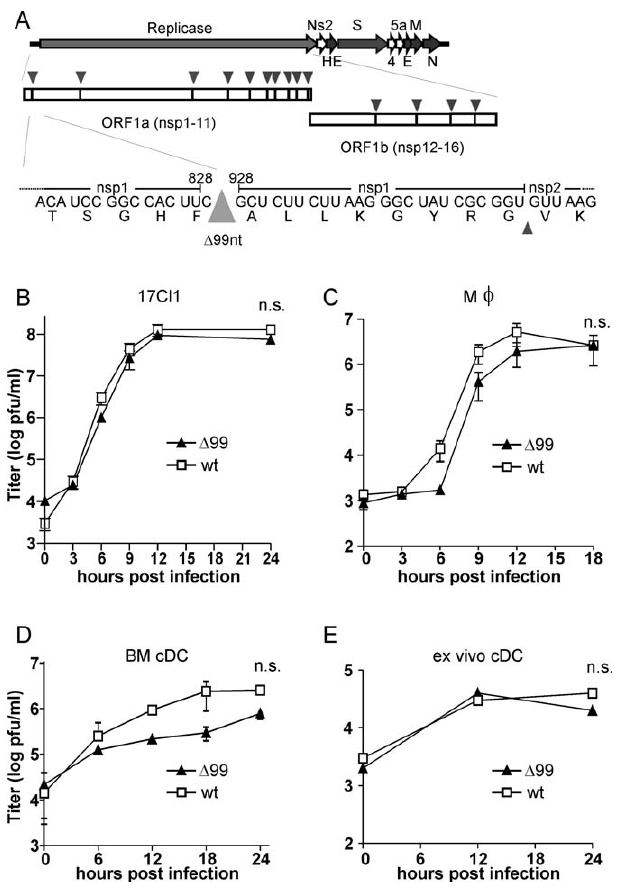
Figure 2. Construction and In Vitro Analysis of MHV-nsp1 D 99 (A) Schematic representation of the MHV-nsp1 D 99 genome organization. The replicase gene, comprised of open reading frames (ORFs) 1a and 1b, is depicted together with viral proteinase cleavage sites (arrowheads) that separate nsps 1–16. The 99-nt deletion within the nsp1-coding region of MHV-nsp1 D 99 is illustrated on the nucleotide and amino acid level. The arrowhead (far right) indicates the nsp1/nsp2 cleavage site. (B–E) Growth kinetics of MHV-nsp1 D 99– or MHV-A59–infected (MOI ¼ 1) murine 17Clone1 cells (B), inflammatory macrophages (C), bone marrow– derived cDCs (D), and ex vivo cDCs (E). Experiments (C–E) were performed with cells obtained from C57BL/6 mice. Results represent the mean 6 SD of two independent experiments. Statistical analysis was performed using Student’s t -test (n.s., p .